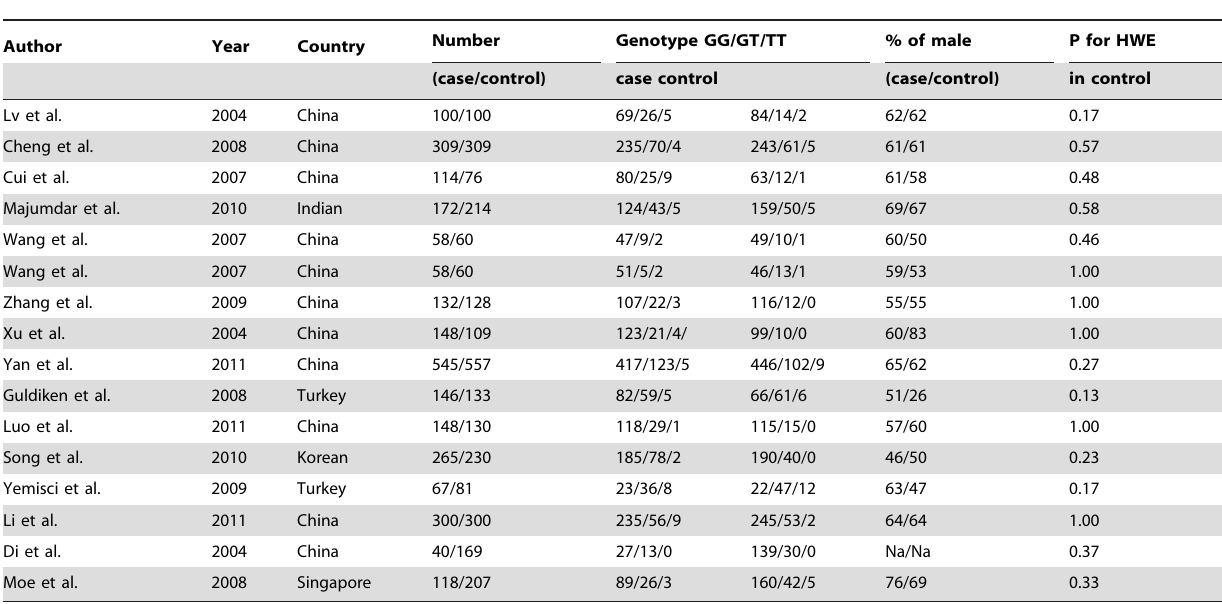
Table 3. Characteristics of eNOS gene G894T polymorphism genotype distributions in studies included in this